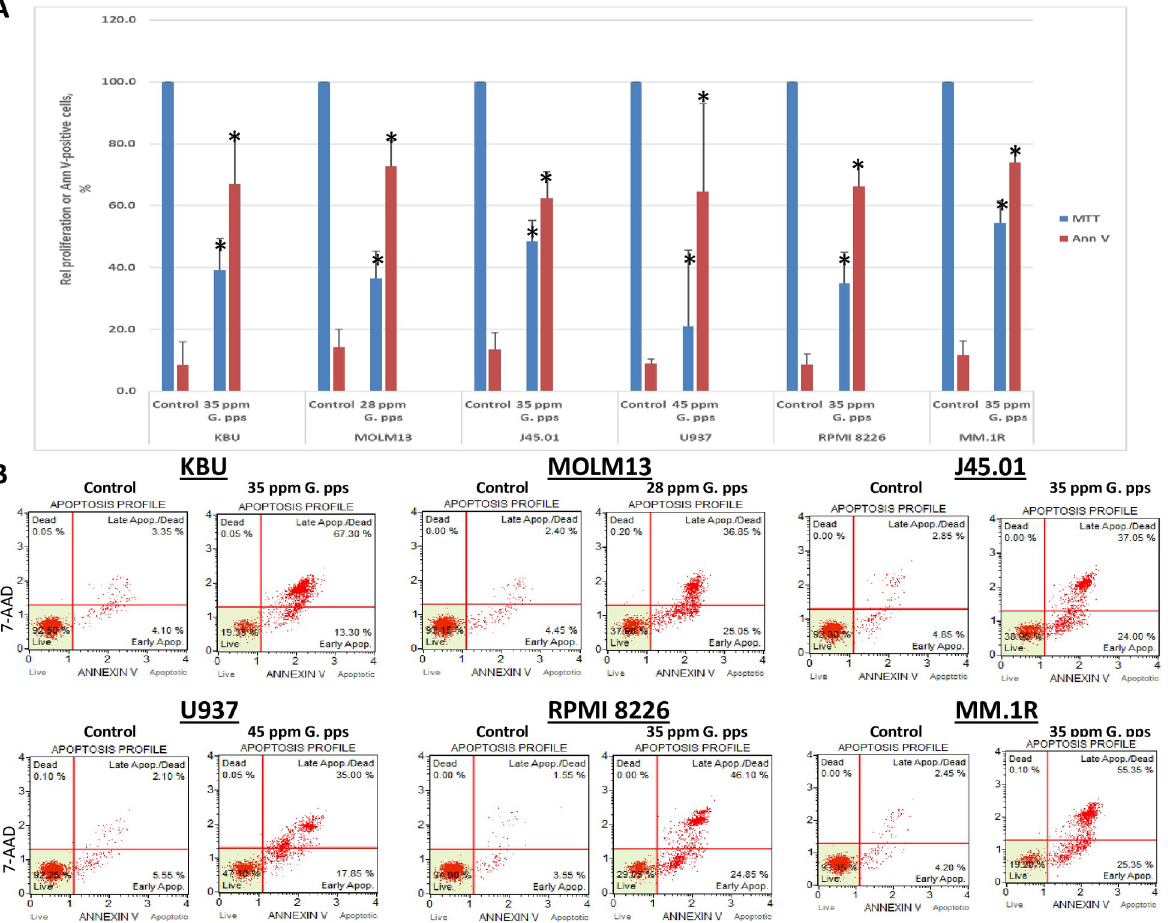
Fig 2. Extract from Gymnopilus purpureosquamulosus ( G . pps ) is cytotoxic towards hematologic malignant cells. (A) Leukemia, lymphoma and multiple myeloma cell lines were exposed to DMSO (Control) or the indicated concentrations of G . pps extract for 48 h and analyzed by MTT and annexin V (Ann V) assays. Rate of proliferation was calculated relative to control. The results are average ( ± standard deviation) of four independent experiments. For each experiment the MTT assay was done in triplicate and Ann V was done once. (B) Representative plots for Ann V assay by flow cytometry are shown (2,000 events). Asterisk ( � ) denotes P < 0.01 compared with control.